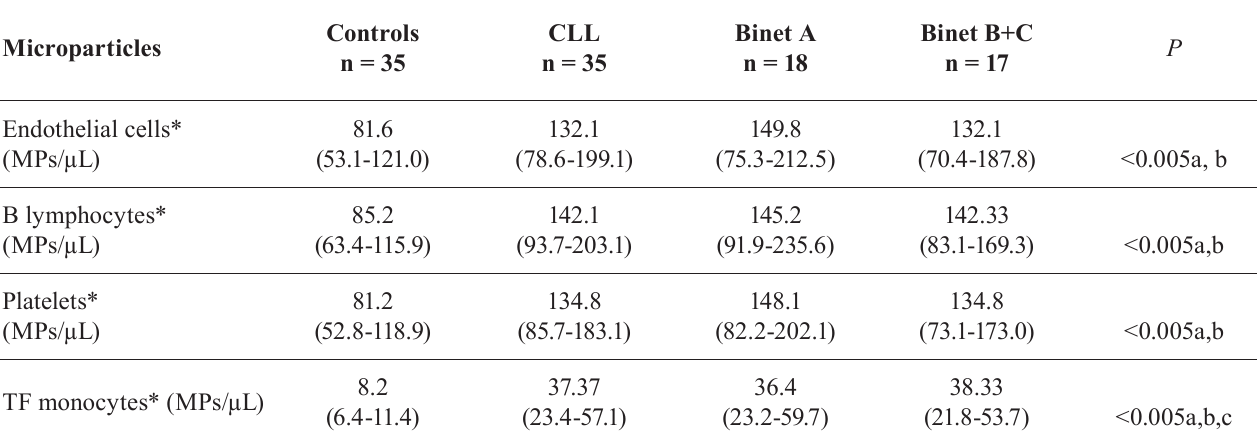
TABLE II - Medians and interquartile range values for circulating microparticles in plasma samples from patients with CLL and